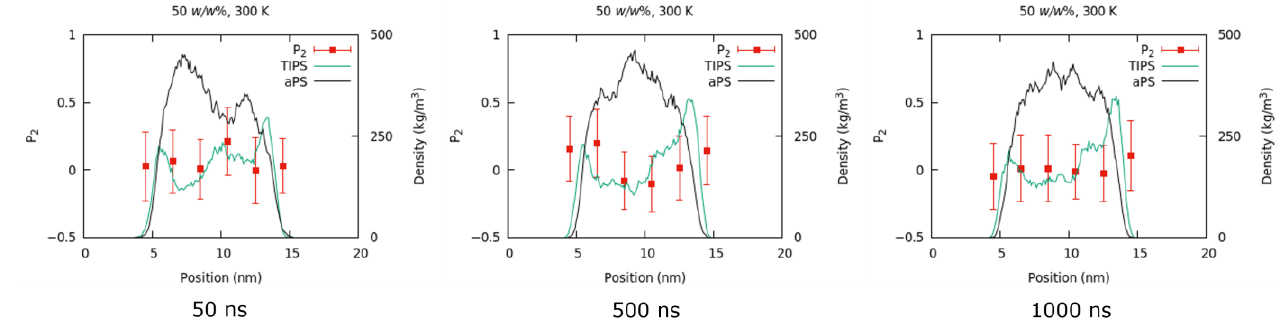
Figure 6. Density profiles of aPS (black curve) and TIPS-P (green curve) together with the P 2 order parameters of TIPS-P for the systems with 50 w/w% toluene at 300 K.